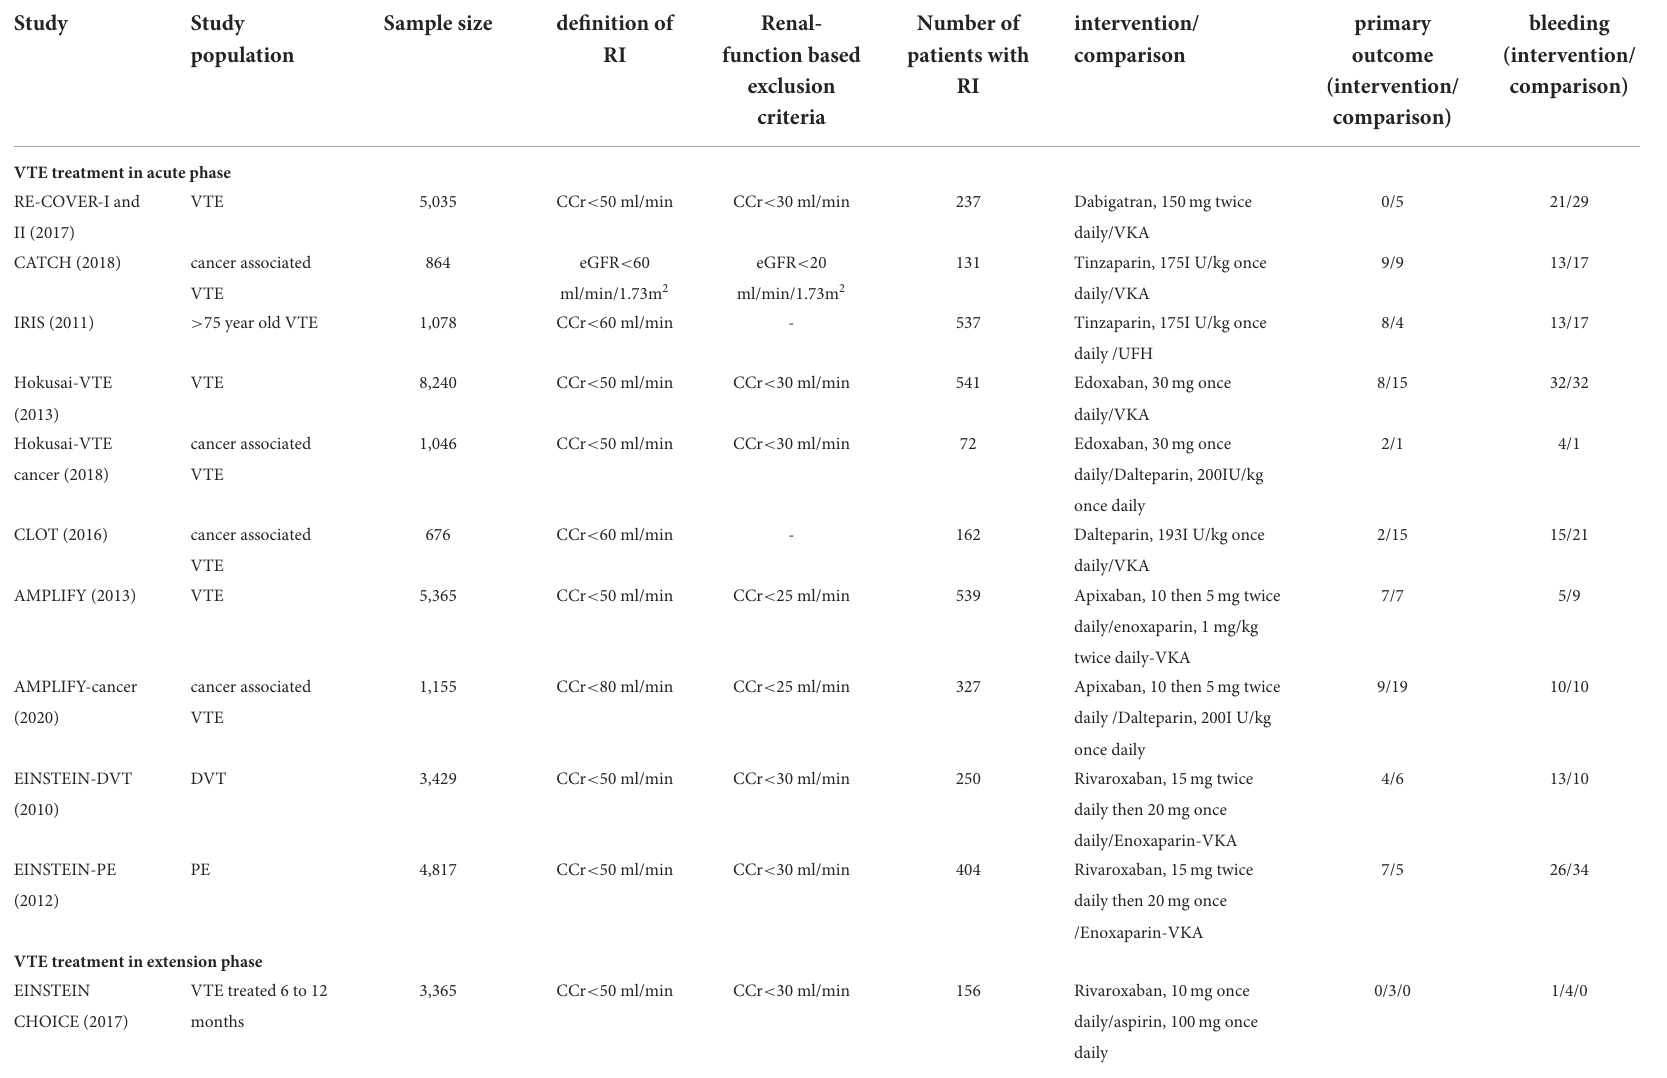
TABLE 1 Summary of studies included in network